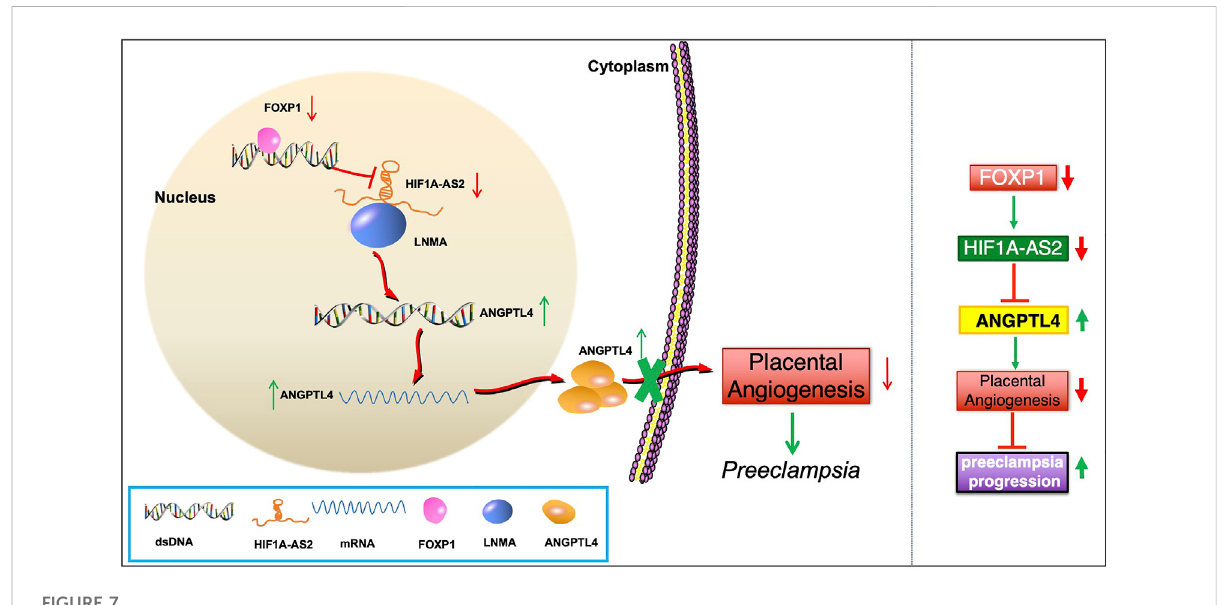
FIGURE 7 Schematic of the regulatory